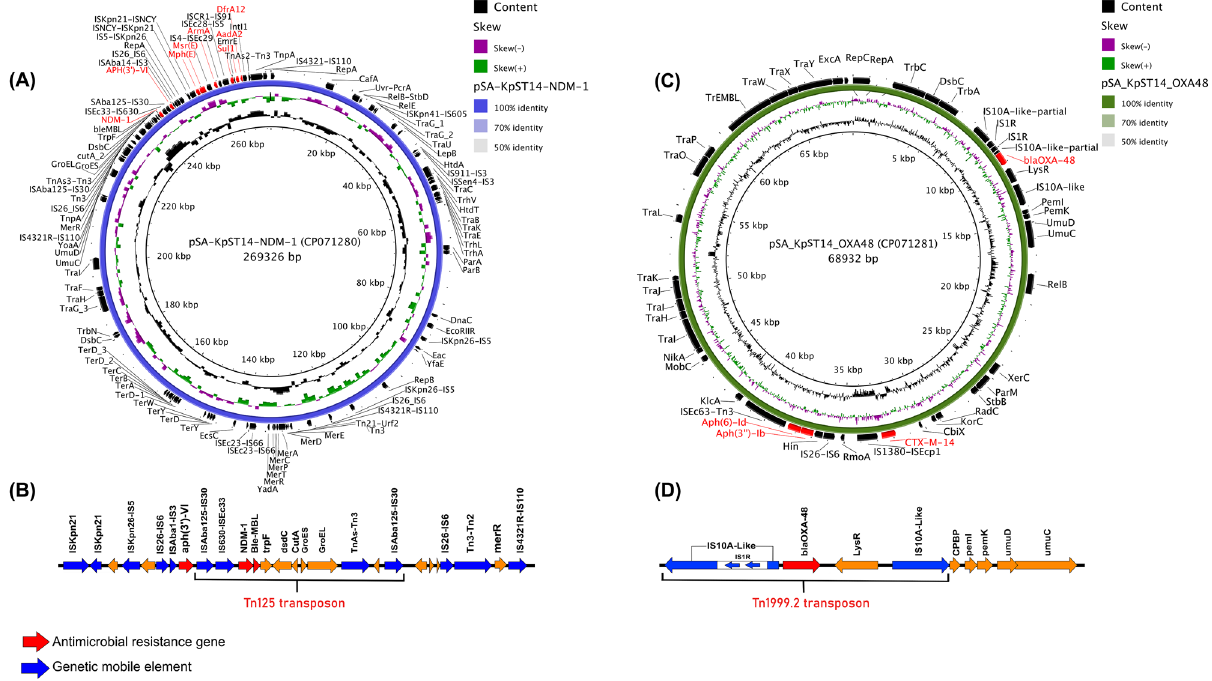
Figure 2. Sequence representation of the two carbapenemase-encoding plasmids carried by the SA-KpST14 isolate. ( A ) Genetic structure of pSA-KpST14-NDM-1 plasmid, ( B ) Gene composition of the bla- NDM-1 -bearing Tn125 transposon, ( C ) Genetic structure of pSA-KpST14-OXA48-2 plasmid, ( D ) Gene composition of the bla OXA-48 -bearing Tn1999.2 transposon. The circular map was generated with the Blast Ring Image Generator (BRIG) 59 software and the schematic diagram of the genetic structure was generated with Easyfig 60 .